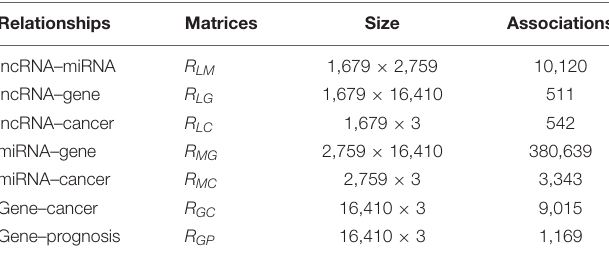
TABLE 1 | The matrix size and the number of associations in the dataset. Relationships Matrices Size Associations